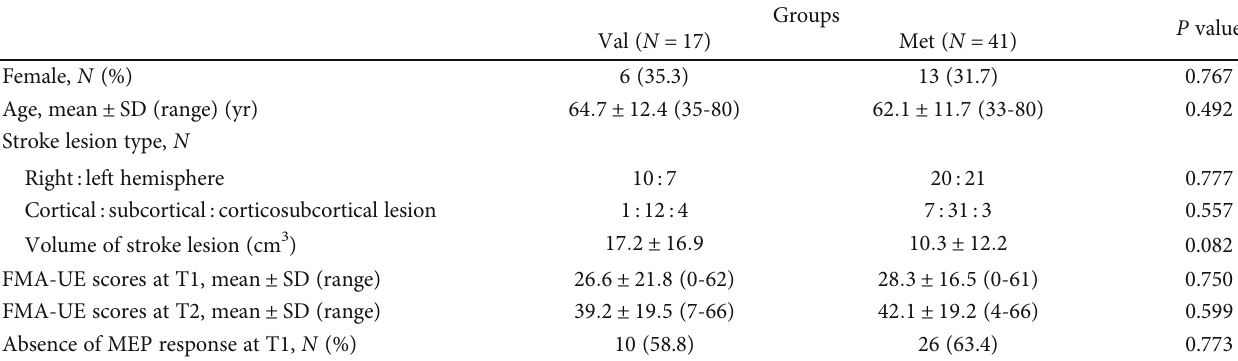
Table 1: Characteristics of participants according to BDNF genotype.